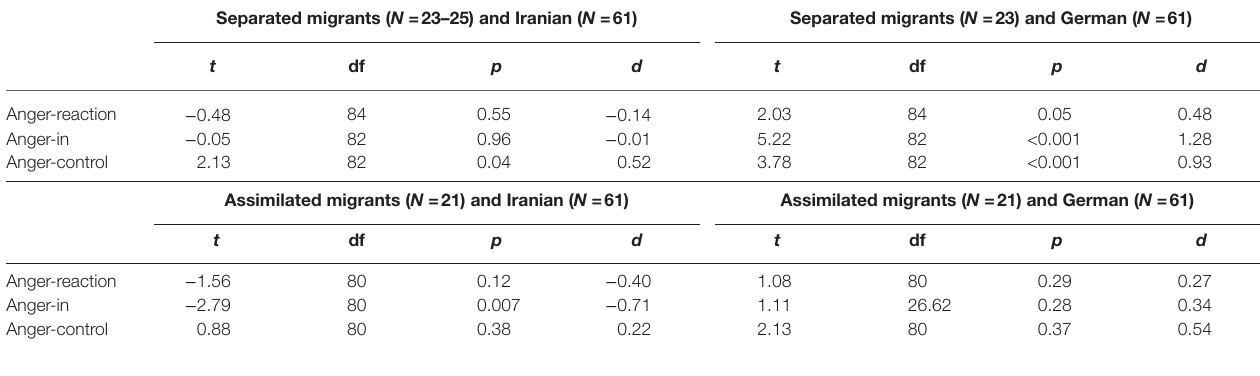
TABLE 6 | Results of several t -tests between separated resp. assimilated migrant samples and an Iranian sample resp. German sample. Separated migrants ( N = 23–25) and Iranian ( N =